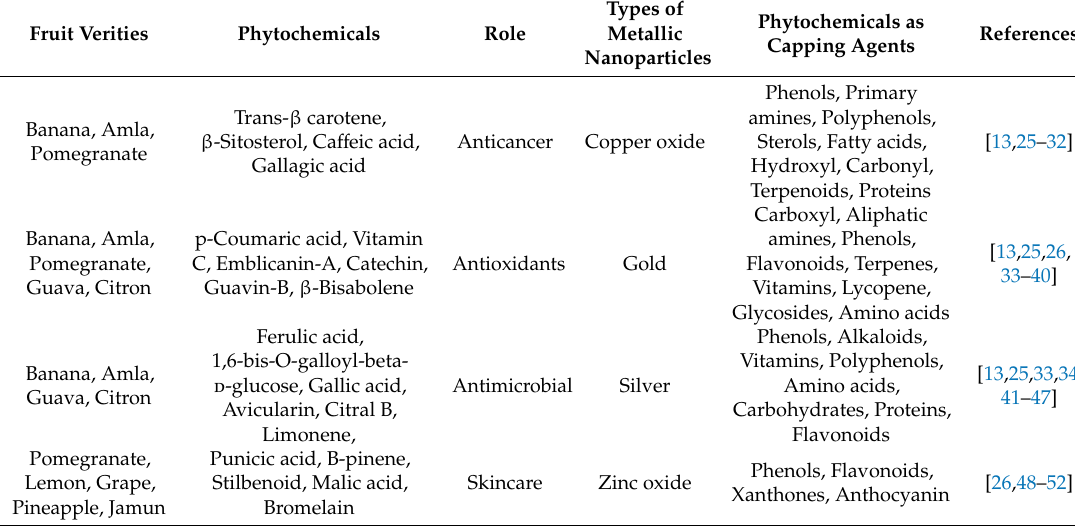
Table 1. Enlist of phytochemicals obtained from fruits with their role as a capping agent in metallic nanoparticles for human